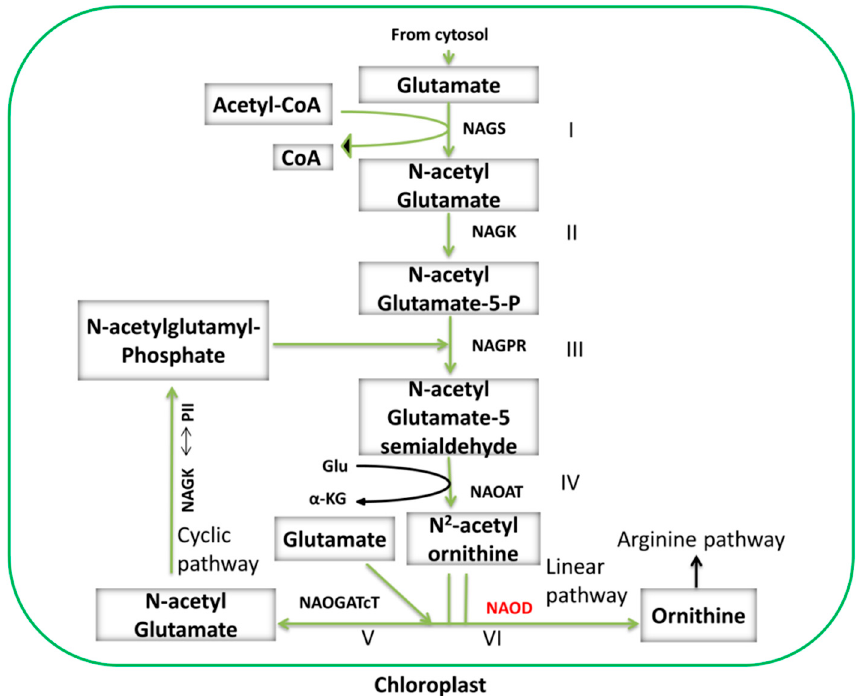
Figure 3. Linear and cyclic ornithine synthesis pathways linked to the arginine metabolic pathway in plants. Arg biosynthesis is divided into two parts and nine discrete steps. In the first part of the pathway, Orn is synthesized from glutamate (Glu), and in the second part, Arg is synthesized from Orn. The first four steps are distinct from the Orn pathway, while the fifth and sixth steps, known as the cyclic and linear pathways, respectively, are also included in the Orn pathway but take different routes. The last three steps (second part) are known as the Arg pathway, which is illustrated in Figure 2. NGS2: N -acetylglutamine synthase; NAGK: N -acetyl glutamate kinase; NAGPR: N -acetylglutamate-5-phosphate reductase; NAOAT: N -acetylornithine aminotransferase; NAOGAcT: N -acetylornithine-glutamate acetyltransferase; NAGK/PII (a plastid localized protein) double-headed arrow: regulatory interaction between the NAGK and PII proteins; NAOD: N -acetylornithine deacetylase.